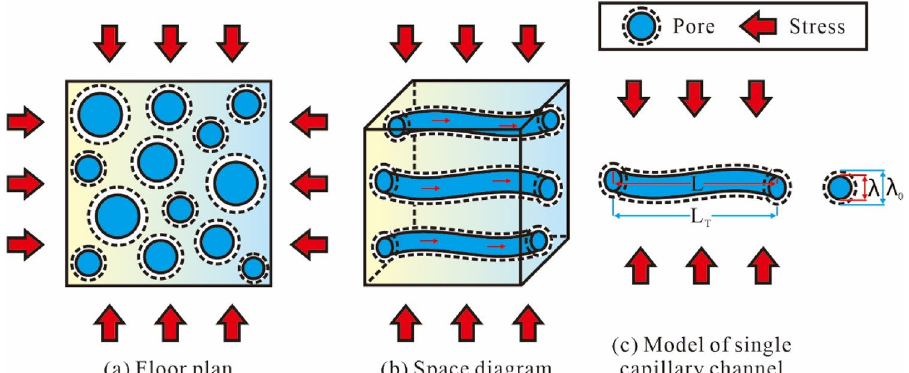
Fig. 3 Diagram of the stress sensitivity in the capillary bundle model (Fuyong